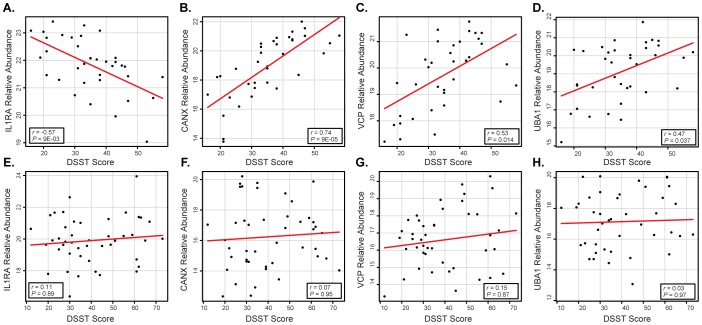
Differences in HIV+ vs. HIV− scatter plots of DSST/protein abundance correlation analyses results for four salivary proteins of interest.(A–D) Scatter plots showing the correlation of specific salivary protein abundance values against measured DSST scores in HIV+, heroin dependent individuals. The proteins include IL1RA (interleukin-1 receptor antagonist), CANX (calnexin), VCP (valosin-containing protein), and UBA1 (ubiquitin-like modifier-activating enzyme 1). All proteins, except for IL1RA, show significant direct correlation of DSST with salivary protein abundance at P-value<0.05. (E–H) Scatter plots showing the same comparison except against HIV− heroin dependent individuals; however, no perceived correlation is observed, i.e., all p-values are well above 0.05. The linear regression is shown by a red line, and the Pearson product-moment correlation score (r) and Benjamini-Hochberg corrected P-values are indicated in the inlay boxes.